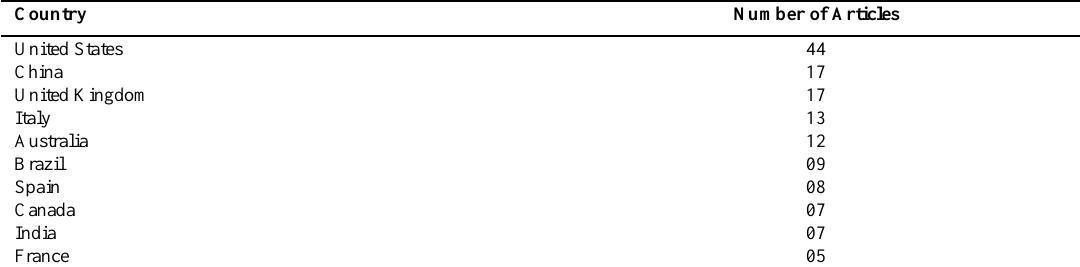
Table 5. Publications of top 10 countries: intellectual capital and operational excellence Country Number of Articles United States